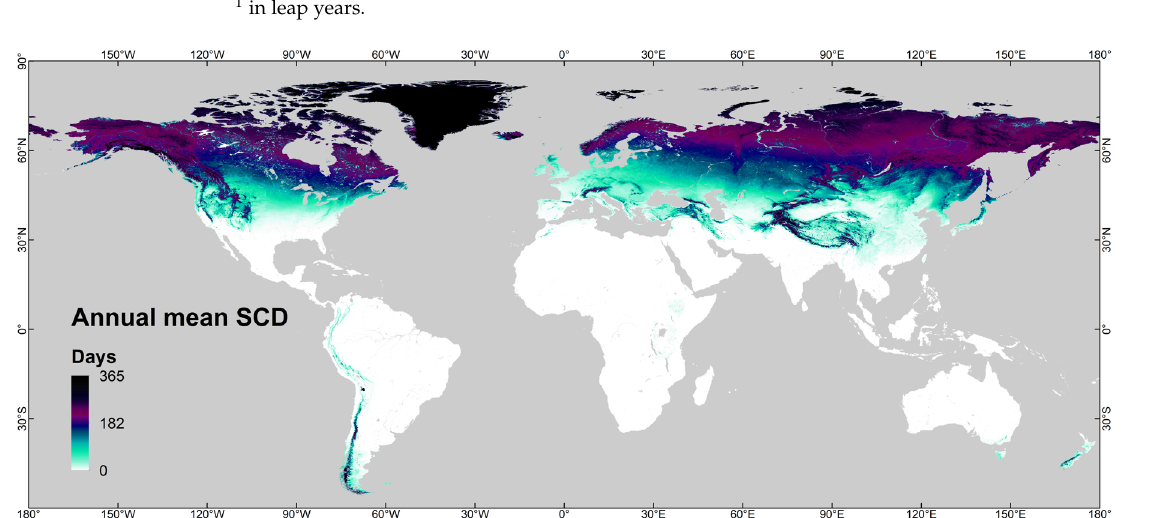
) derived from 23 hydrological years (2000–2022). 𝑁𝑁𝑓𝑓𝑁𝑁 𝑓𝑓𝑓𝑓𝑓𝑓𝑓𝑓 ����������